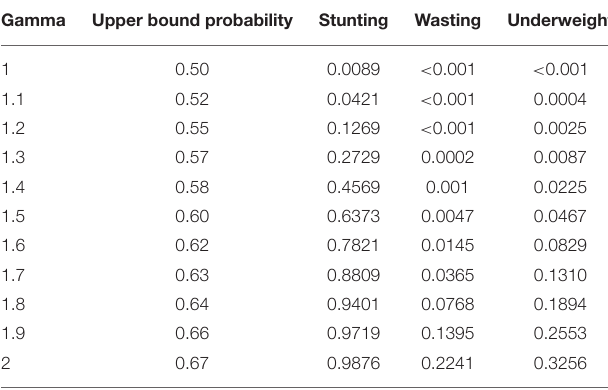
TABLE A1 | Sensitivity analysis - Rosenbaums upper bounds for stunting, wasting and underweight.